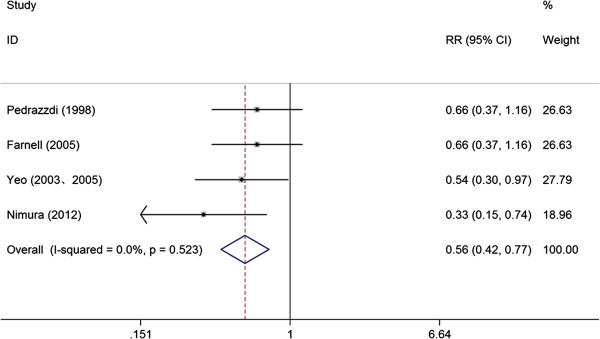
Forest plot for the incidence of postoperative complications between the pancreatoduodenectomy with extended lymphadenectomy (PD/ELND) group and the standard pancreatoduodenectomy (PD) group. The size of the black box corresponding to each study is proportional to the sample size, and the horizontal line shows the corresponding 95% CI of the relative risk (RR) displayed on the right.